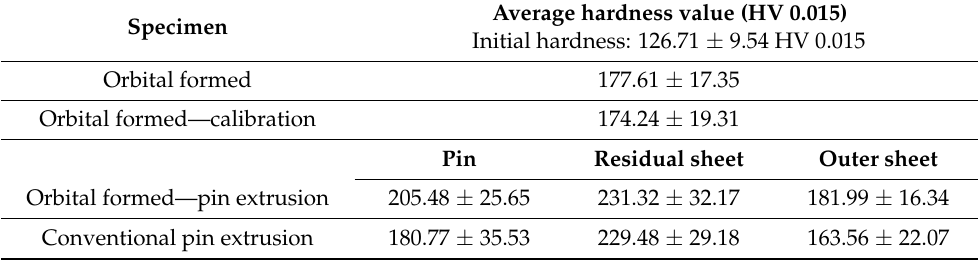
Table 2. Average hardness values for the orbital formed and calibrated samples as well as average values for both pin extrusions in the specific local